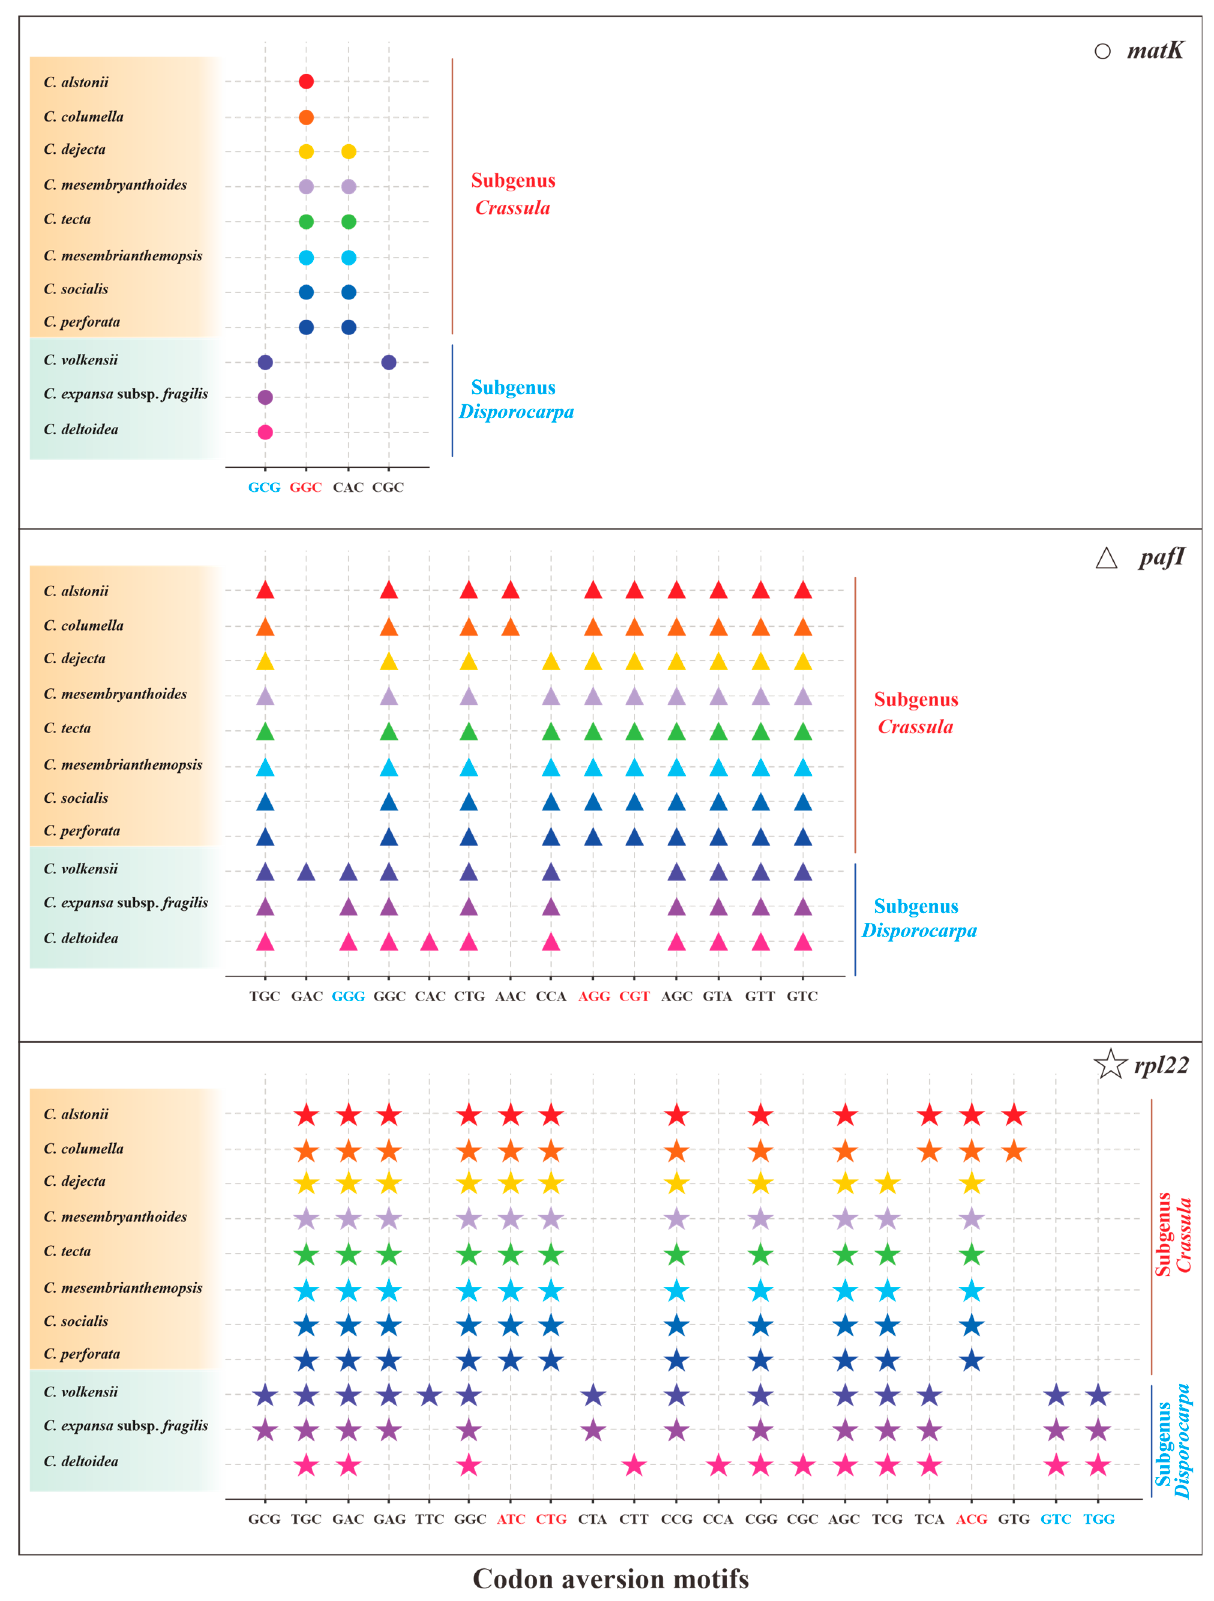
Figure 8. The specific codon aversion motifs of matK , pafI and rpl22 gene for the 11 species of Crassula . The dots marked in different colors represent different species. Codons in red and green were specific for subgenus Crassula and subgenus Disporocarpa , respectively.